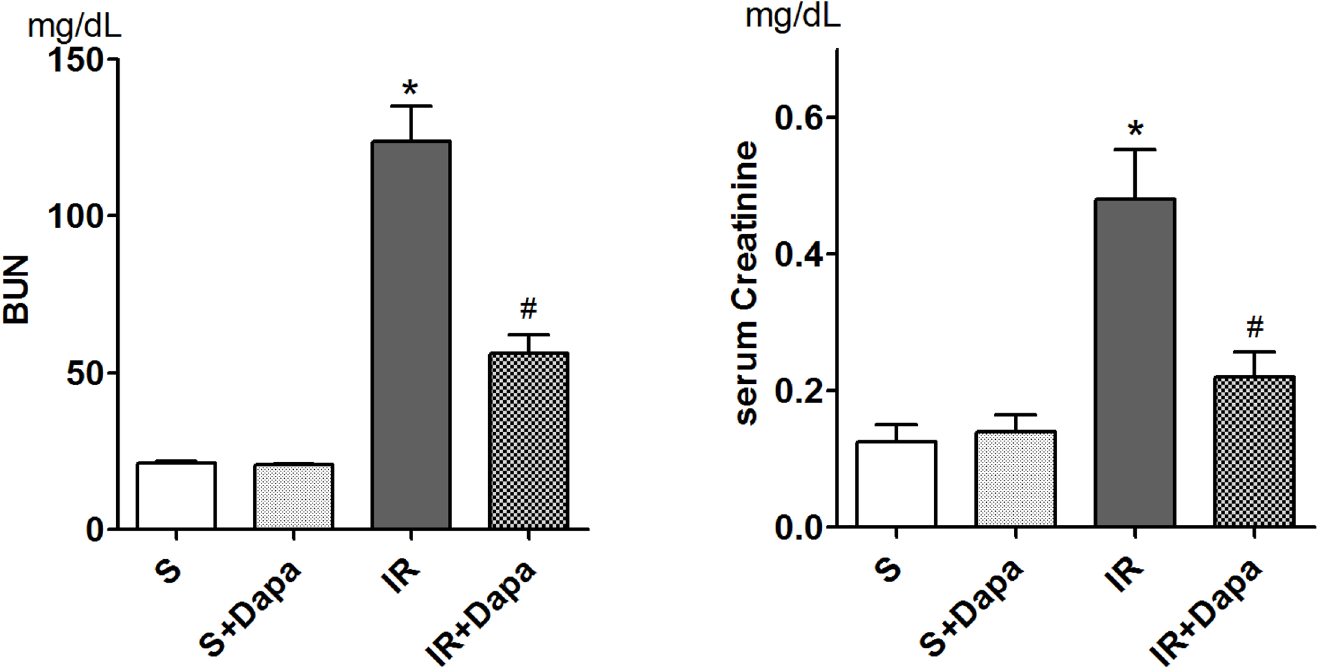
Fig 1. Effects of dapagliflozin on renal function (S(n = 5), sham; S + Dapa (n = 5), sham + dapagliflozin; IR(n = 7), vehicle-treated renal IR mice; IR + Dapa (n = 7), dapagliflozin-treated IR mice). Dapagliflozin pretreatment reduced BUN and serum creatinine in IR-injured mice. * P < 0.05 vs. vehicle-treated sham, # P < 0.05 vs. vehicle-treated IR. Bar represents mean ± s.d.(Standard deviation).